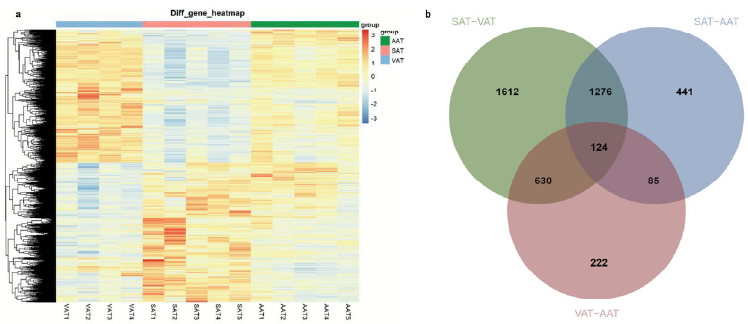
Figure 2. Volcano plots of differentially expressed genes in SAT − VAT ( a ), SAT − AAT ( b ), and VAT − AAT ( c ) comparative groups. The red and green dots represent the up ‐ regulated and down ‐ regulated genes, respectively.